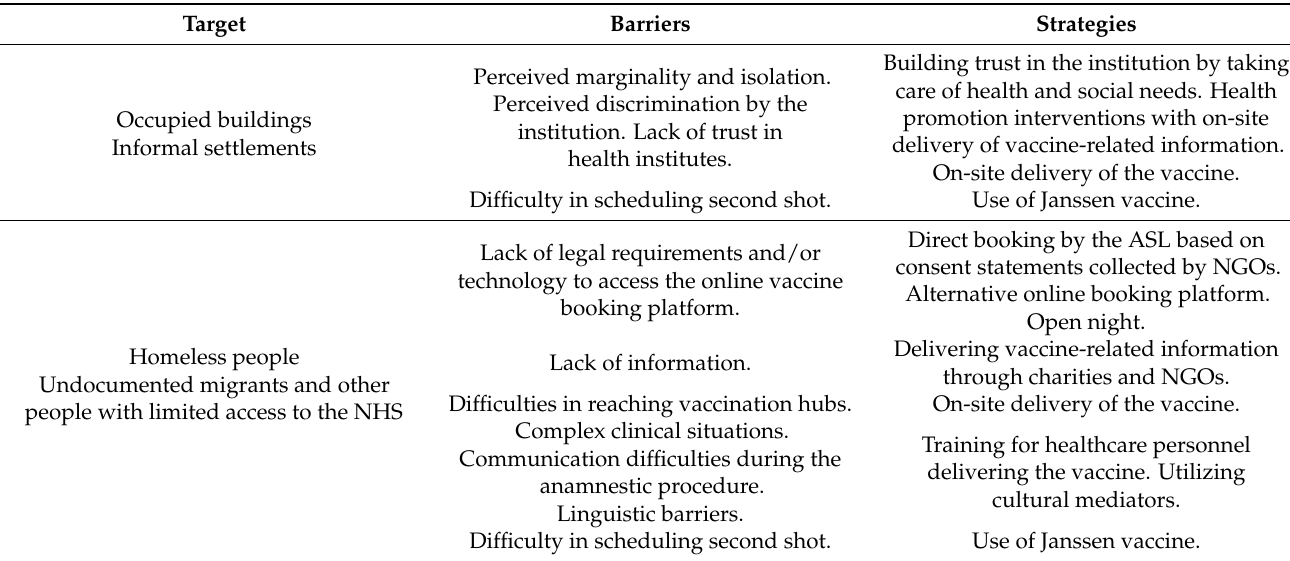
Table 1. Analysis of barriers to vaccination and strategies to overcome